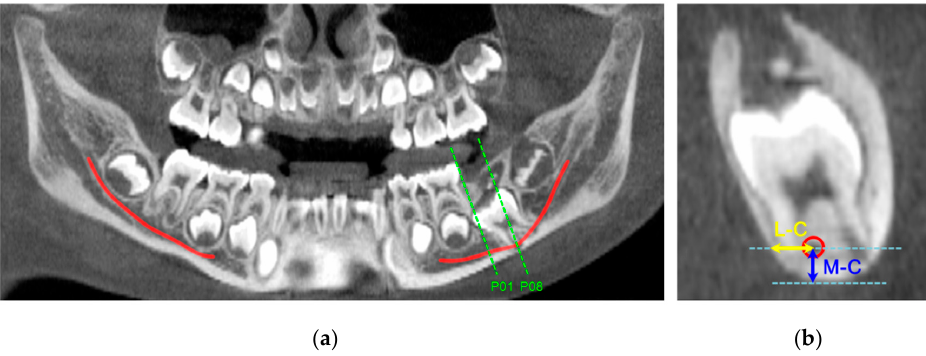
Figure 1. Cone-beam computed tomography (CBCT) imaging of study patients analyzed using OnDemand 3D software. ( a ) Reconstructed panoramic view with nerve tracing in permanent mandibular first molars (PM1) areas. Red lines indicate positions of the mandibular canals on this panoramic view. The green line (noted P01) indicates the first measurement point on the cross-sectional view of this PM1 in the ED group; ( b ) Cross-sectional CBCT image displaying measurement point P08. M–C refers to the distance from the most inferior margin of the mandible to the center of the mandibular canal. L–C refers to the distance from the outer margin of the lingual cortex to the center of the mandibular canal. A red circle indicates the mandibular canal.